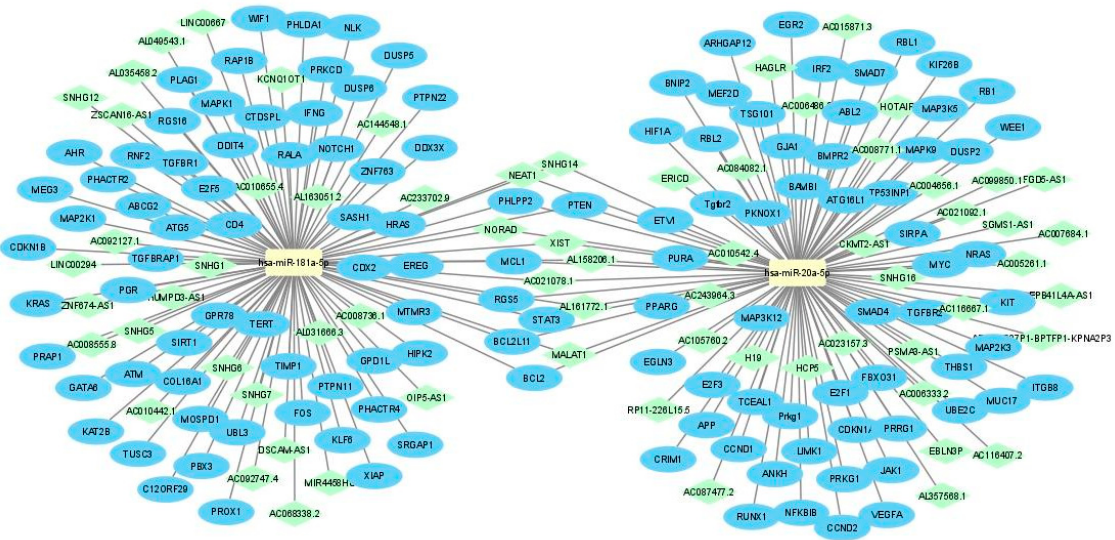
Figure 3. Data integration of the lncRNA–miRNA–mRNA networks related to hsa-miR-20a-5p and hsa-miR-181a-5p.